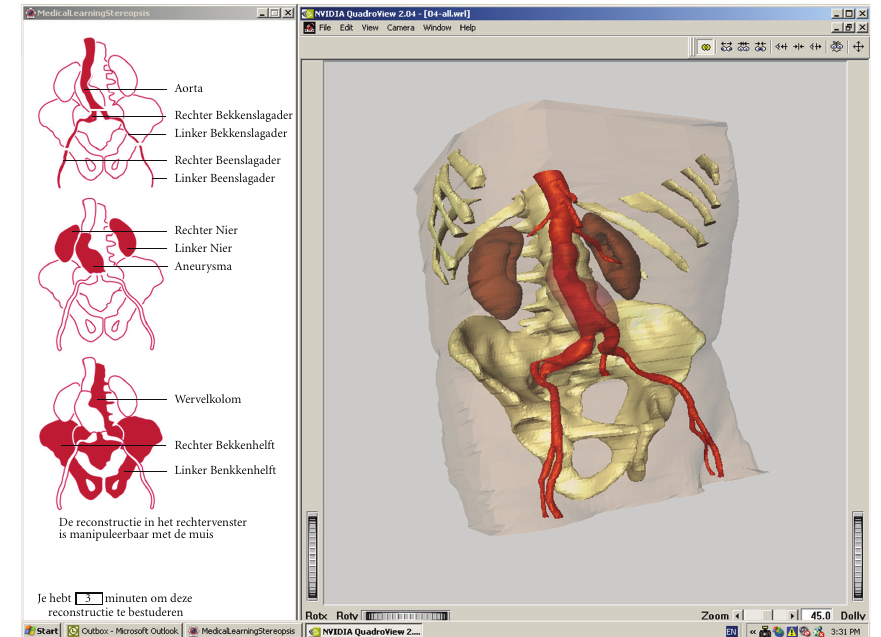
Figure 1: Screenshot of the study phase. Participants either actively manipulated the 3D anatomy on the right or passively watched the manipulations of the active